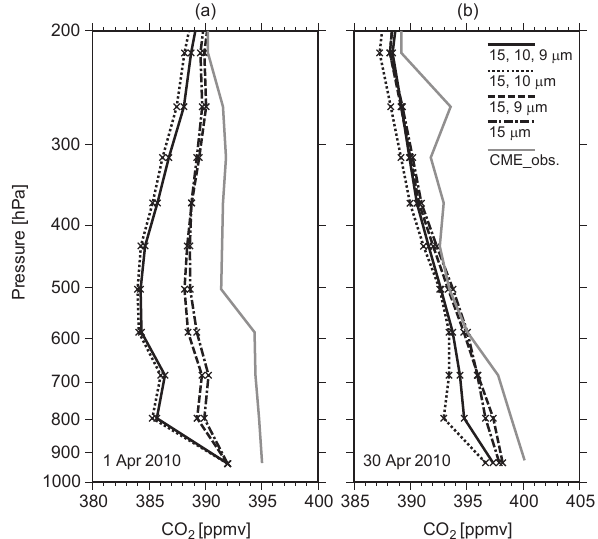
Figure 10. CO 2 profiles over Narita airport retrieved using four dif- ferent wavelength bands of GOSAT/TANSO-FTS V161 L1B spec- tra: three bands, 15, 10, and 9µm (solid lines); two bands, 15 and 10µm (dotted lines); two bands, 15 and 9µm (dashed lines), and the 15µm band only (dashed-dotted lines). Nearby CME CO 2 profiles (CME_obs.) are shown by gray lines: (a) a case of 1 April 2010 and (b) a case of 30 April 2010.